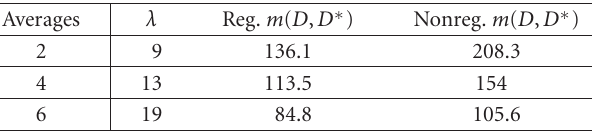
Table 1: The distance m ( D , D ∗ ) of the regularized and the nonreg- ularized tensor fields from the numerical examples shown in Figures 7 and 8.